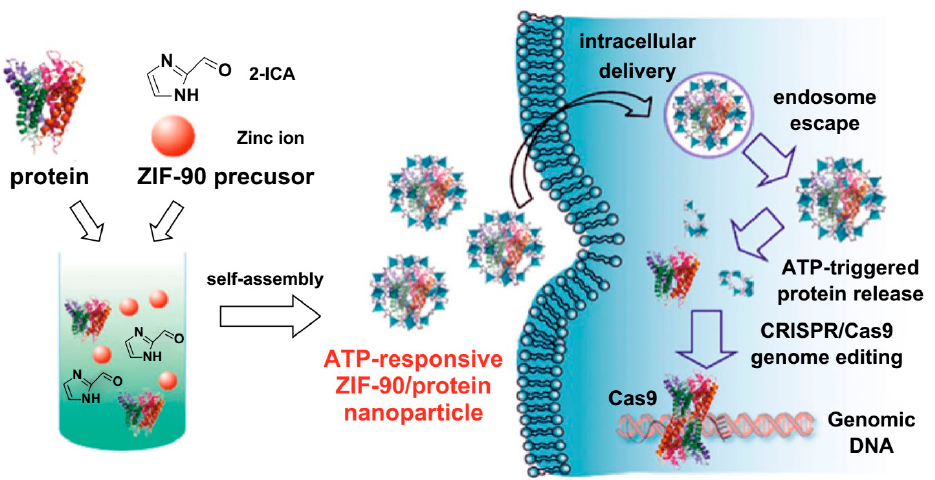
Figure 11. Schematic illustration of the synthesis of ZIF–90/protein nanoparticles and ATP–triggered protein release in the cell. Reproduced from Ref. [142] with permission from American Chemical Society, Copyright 2019.